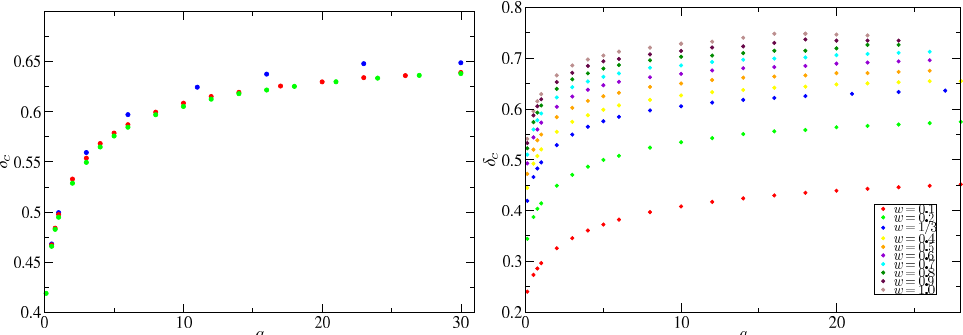
Figure 13. ( Left-panel ): Threshold values δ c in terms of q for the case of w = 1/3. Green points correspond to Equation (82), red points to Equation (83) with λ = 0, and blue to Equation (83) with λ = 1. ( Right-panel ): Threshold values δ c in terms of q for different values of w corresponding to the polynomial profile of Equation